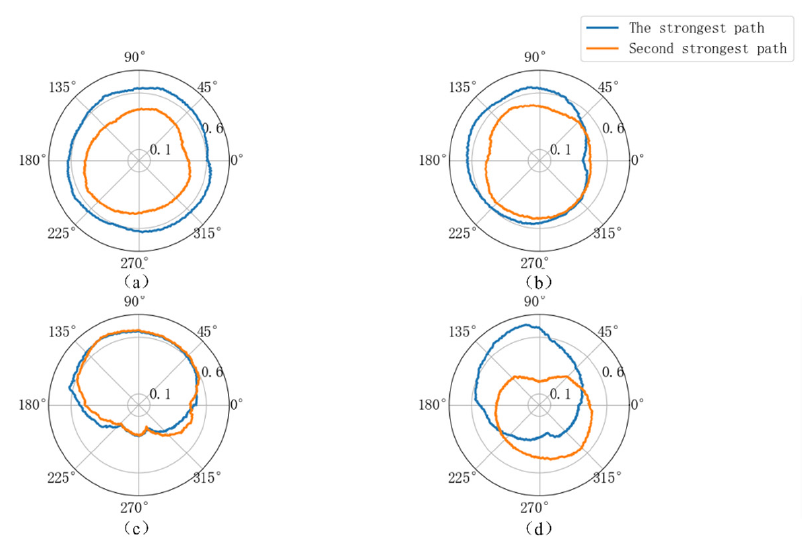
Figure 14. Path activation index PA under different phase shifts of stimulus information ( a ) Both the strongest and the second strongest paths are insensitive to phase. ( b ) Only the strongest path is phase sensitive. ( c ) The strongest and second strongest paths are sensitive to the same phase offset. ( d ) The strongest and second strongest paths are sensitive to different phase